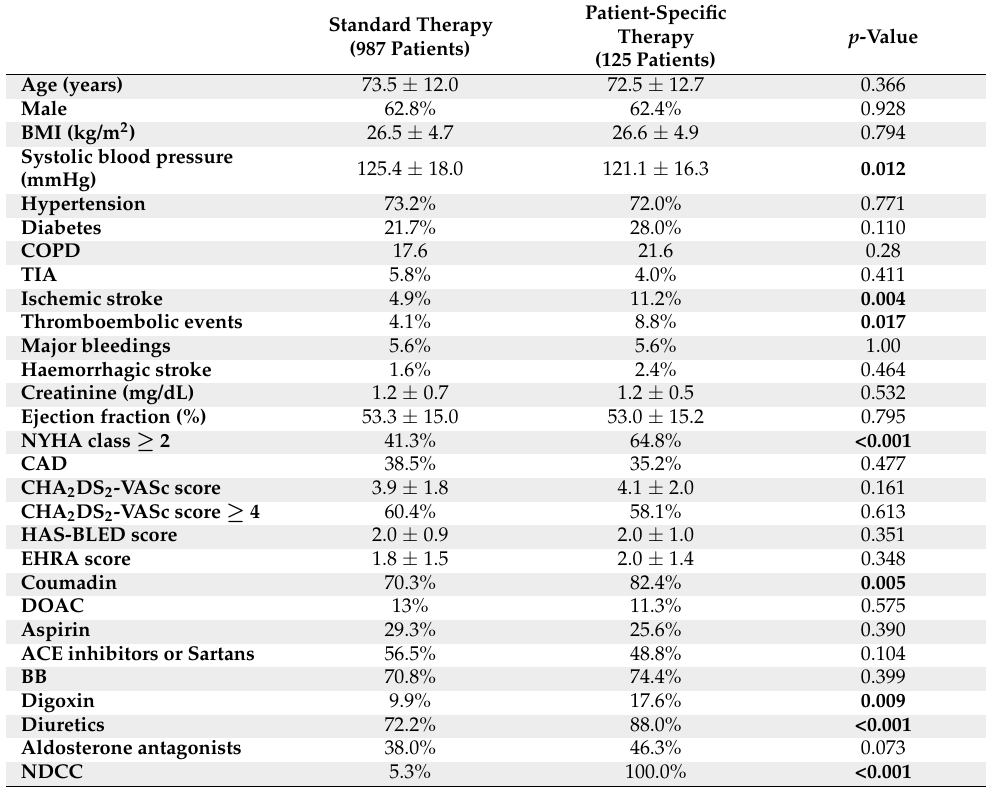
Table 1. Baseline characteristics of the standard therapy and patient-specific therapy groups.